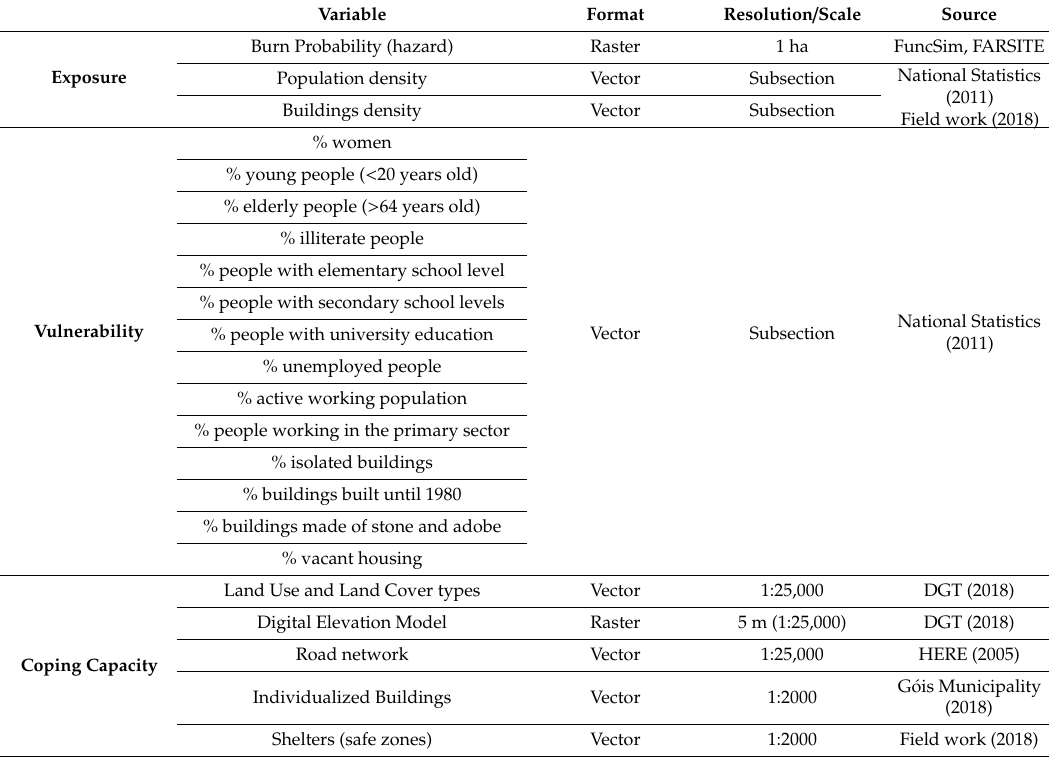
Table 1. Variables used to calculate the di ff erent risk components and their data